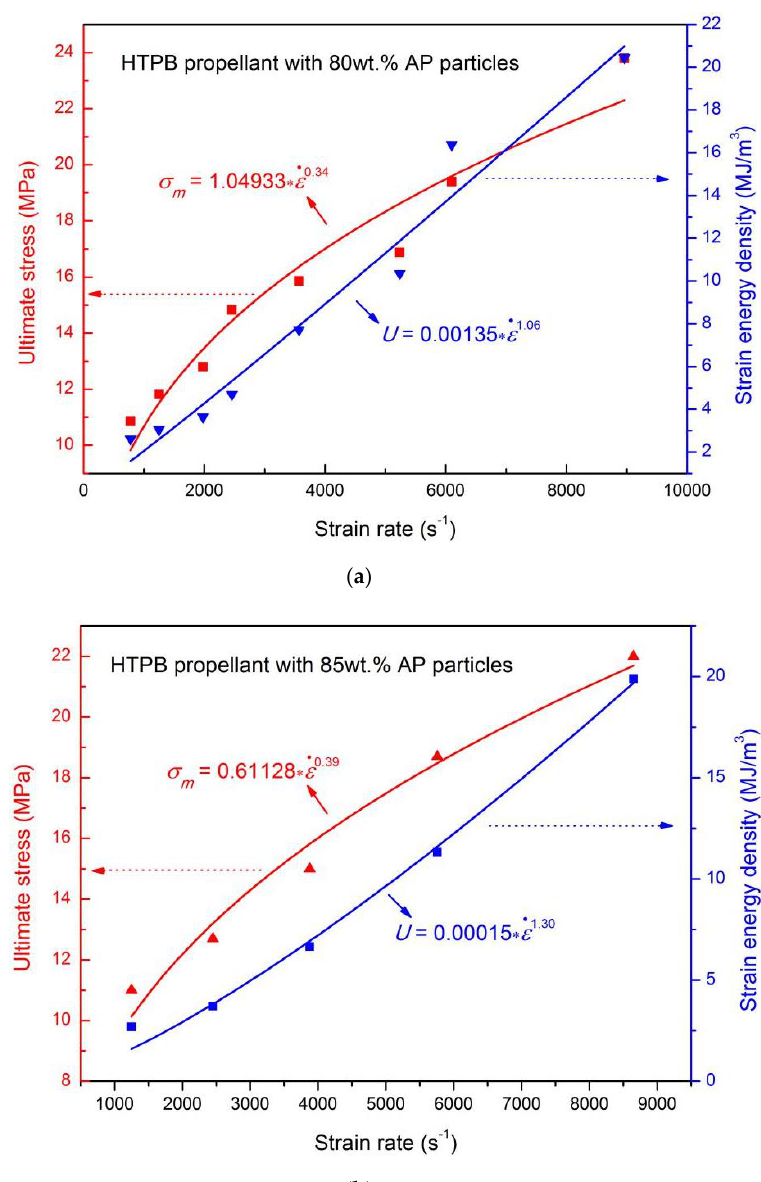
Figure 12. The strain rate dependence on ultimate stress and strain energy density of ( a ) H-80W and ( b ) H-85W. Table 2. Parameters of strain rate dependence on ultimate stress and strain energy density described by a power function in Equations (4) and (5) for H-80W and H-85W. Ultimate Stress ( 𝝈 m ) Sample